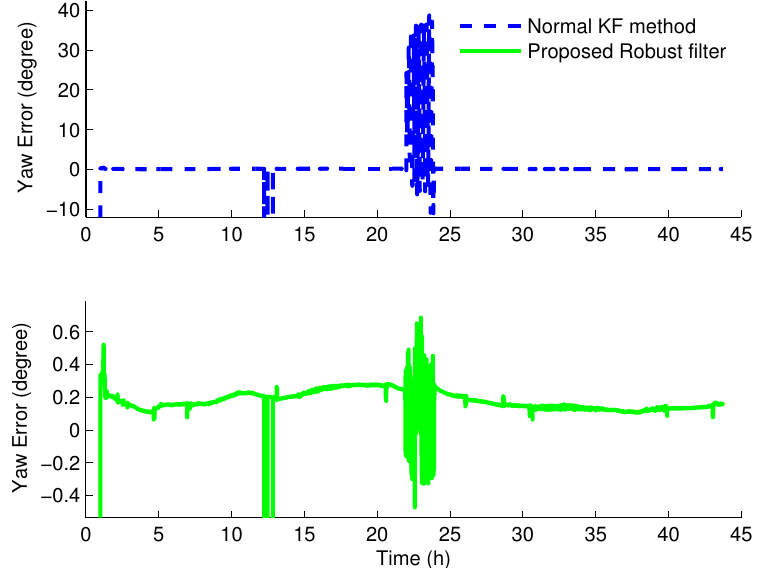
Figure 7. The azimuth angle errors with the normal Kalman filter method and the proposed robust H ∞ filter. The blue dash line indicates the azimuth errors by utilizing the normal Kalman filter method; The green solid line indicates the azimuth errors by utilizing the novel method proposed in this